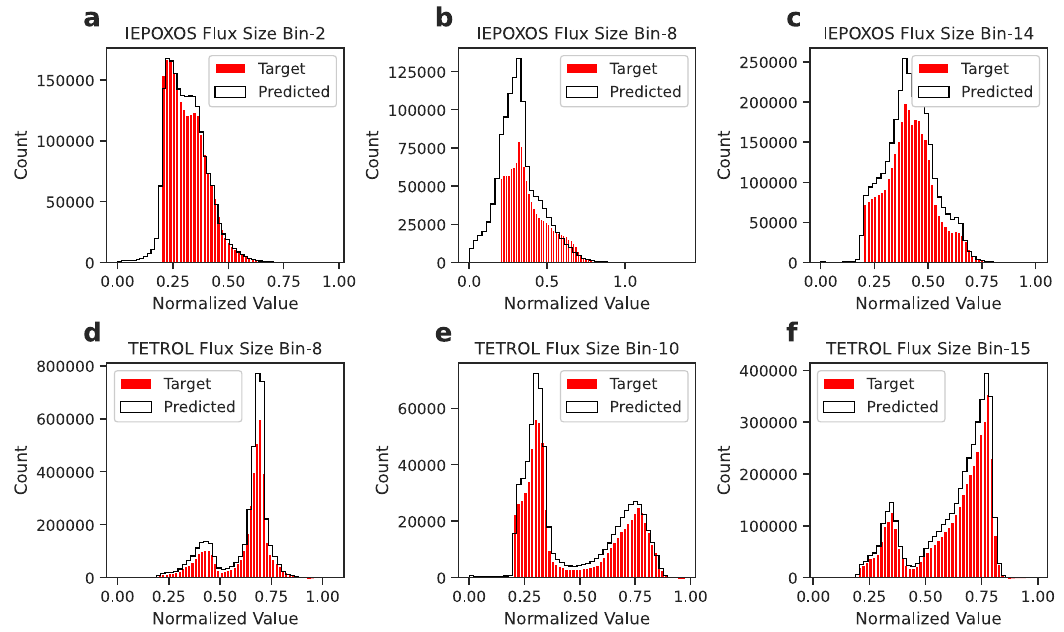
Fig. 2 Rate of change ( fl ux) of IEPOX-SOA components due to aqueous chemistry from the test target data and those predicted by the uncoupled DNN model. (a-c) IEPOXOS particle fl uxes in size bins 2, 8, 14 and ( d – f ) Tetrol particle fl uxes in size bins 8, 10,